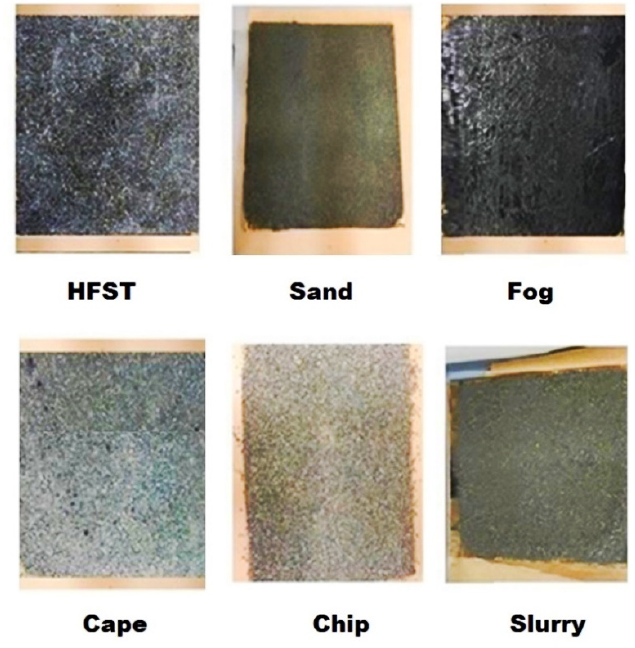
Figure 3. Samples of six simulated sealcoats.